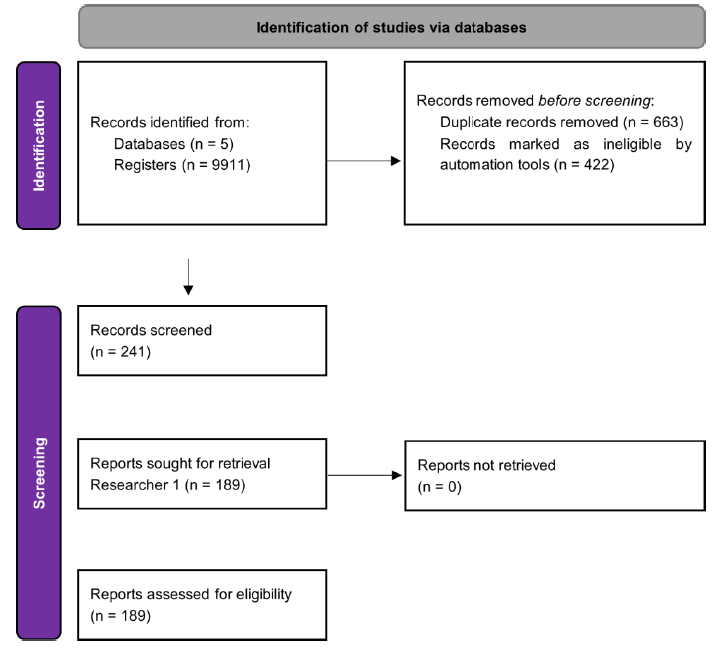
Figure 2. PRISMA flowchart for up-to-date results. Figure 3 schematic presents our proposal for the arrangement of Results in five etiologic categories.